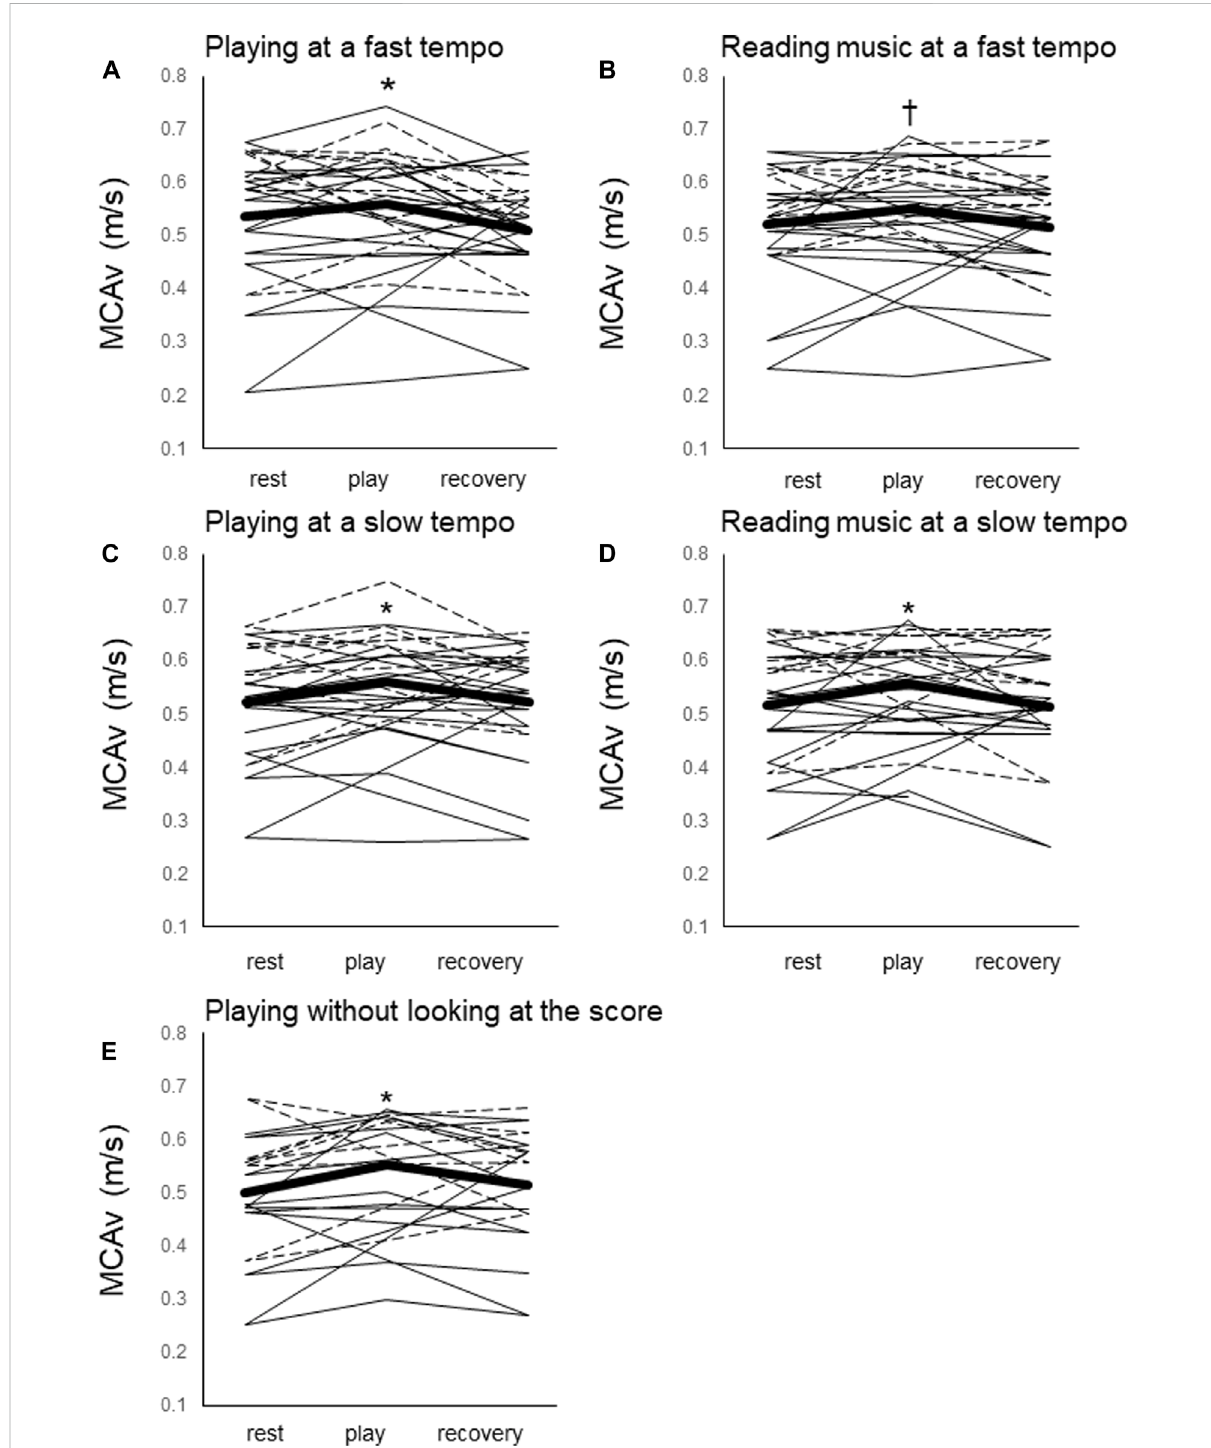
FIGURE 1 Middlecerebralarteryblood fl owvelocity(MCAv)before,during,andafter fi vetrials. (A) Playingatafasttempo(PL80), (B) readingmusicatafast tempo (RE80), (C) playing at a slow tempo (PL60), (D) reading music at a slow tempo (RE60), and (E) playing without looking at the score (ME). Mean values for all participants (thick black line) and individual values for piano players (thin black line) and violin players (dotted line) are shown. *: p < 0.05 vs. resting. † : p < 0.07 vs.